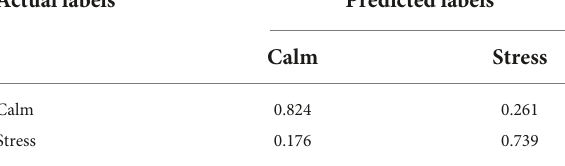
TABLE 3 Stress detection confusion matrix of I3D without temporal attention